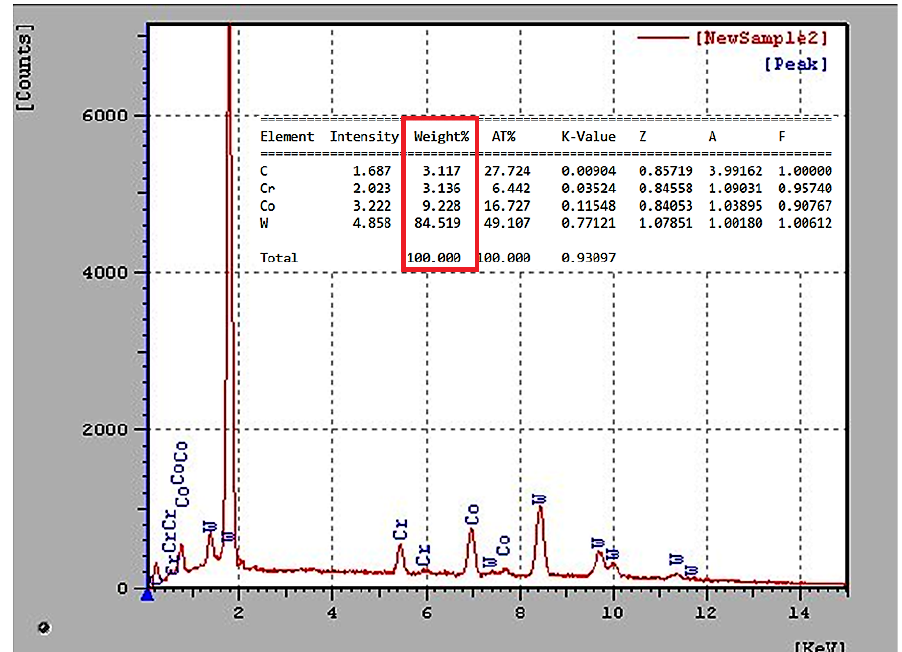
Figure 7. Quantitative pattern of the elemental microanalysis region in the cross-section of the HVOF 86WC-10Co-4Cr coating using the EDS